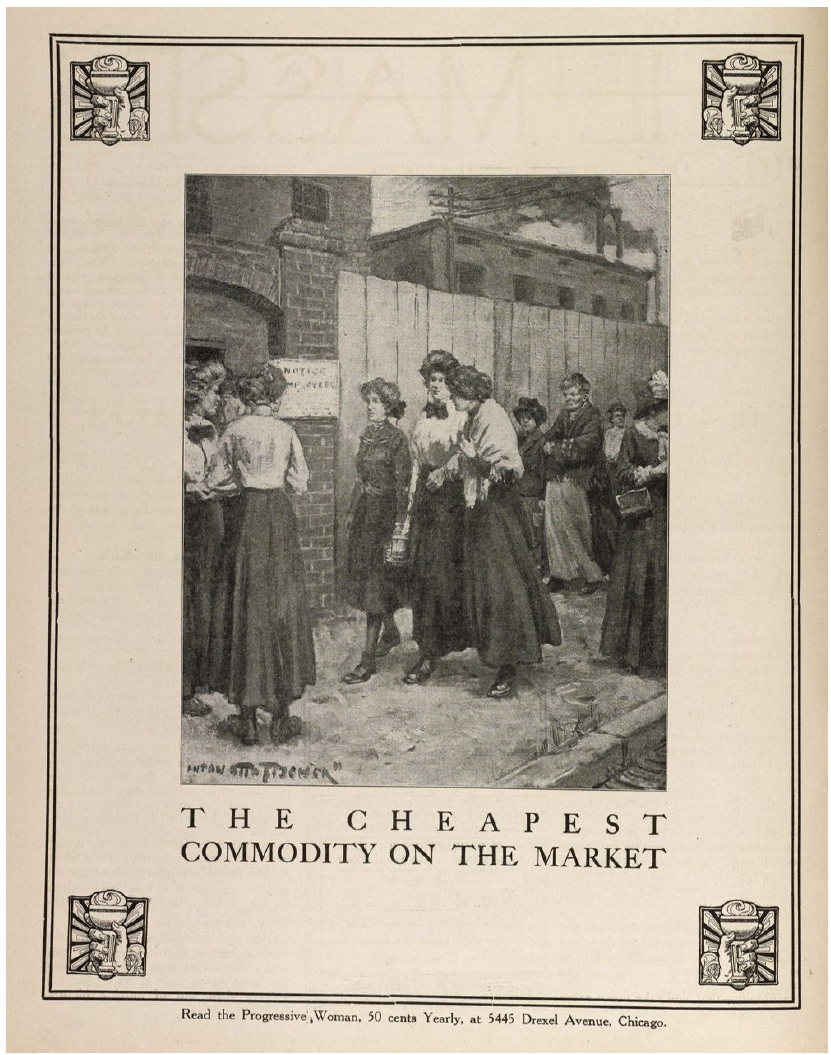
Figure 5. The Cheapest Commodity, frontispiece, by A.O. Fisher. The Masses V. 1. No. 12, (December 1911): p. 4. The Modernist Journals Project. Available online: https://modjourn.org/issue/bdr526900/ (accessed on 29 August 2022).